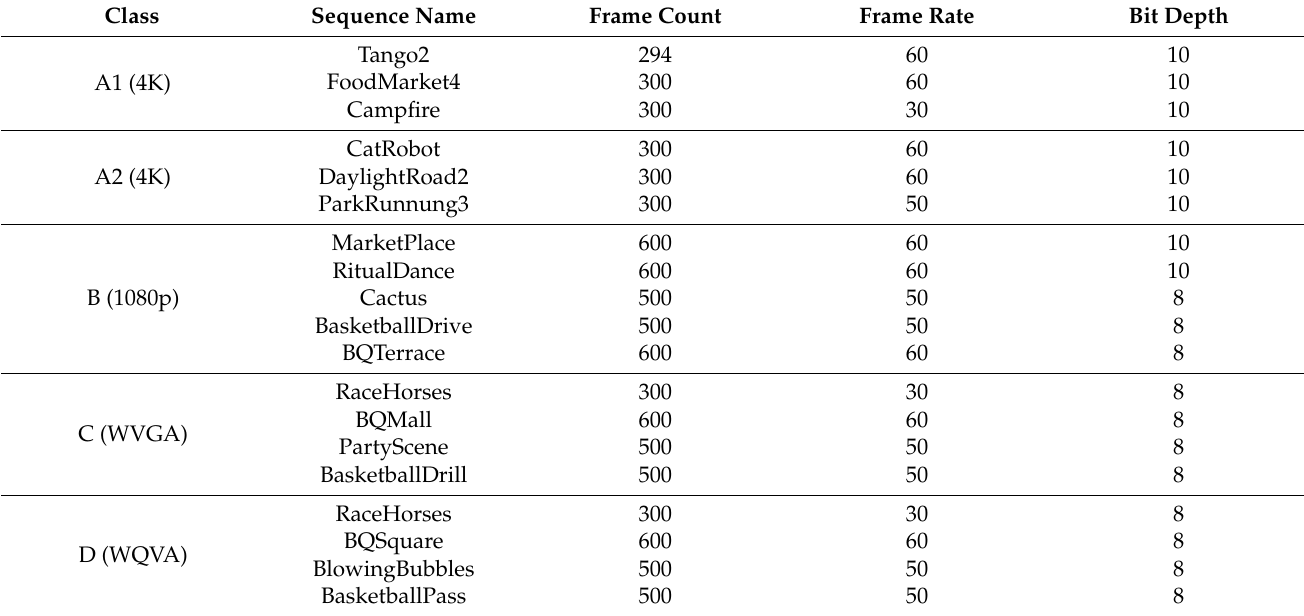
Table 8. Information on video